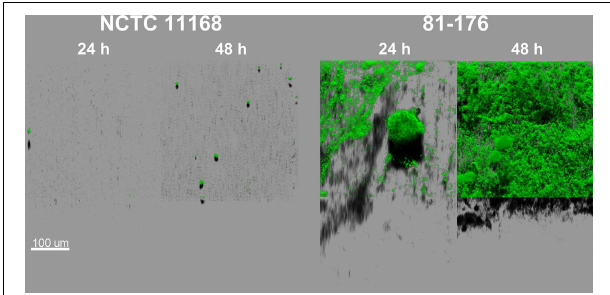
FIGURE 1 | C. jejuni NCTC 11168 and 81-176 biofilm architecture and development are different after incubation for 24 and 48h in MAC (5% O 2 , 10% CO 2 , 85% N 2 ). The CLSM images represent an aerial view of biofilm structures with the shadow projection at the bottom. The structures were visualized using Syto 9, an intercalating agent staining the nucleic